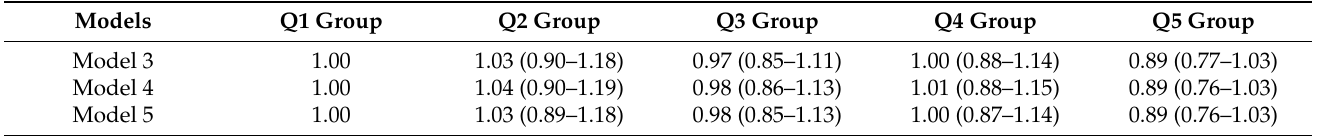
Table 4. The association between DASH dietary groups and incident hyperuricemia using an alternative